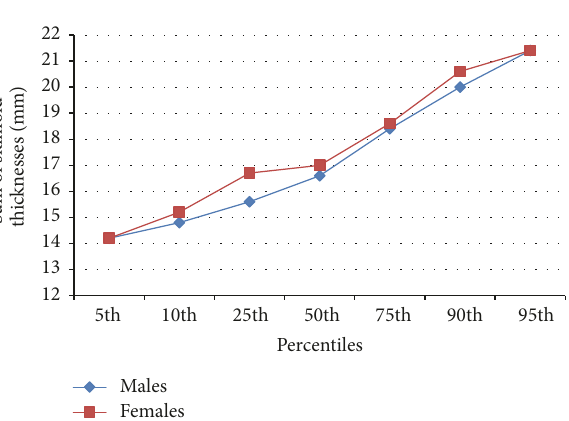
Figure3:Percentilevaluesforsumofskinfoldthicknessesatvarious sites in males and females.